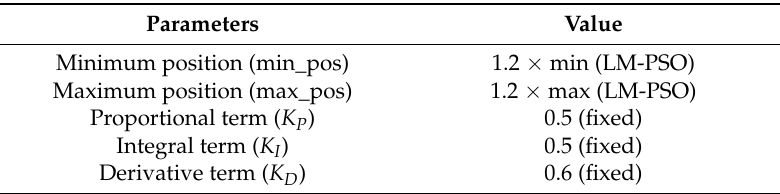
Table 2. Parameter information of the PSOpid-based method